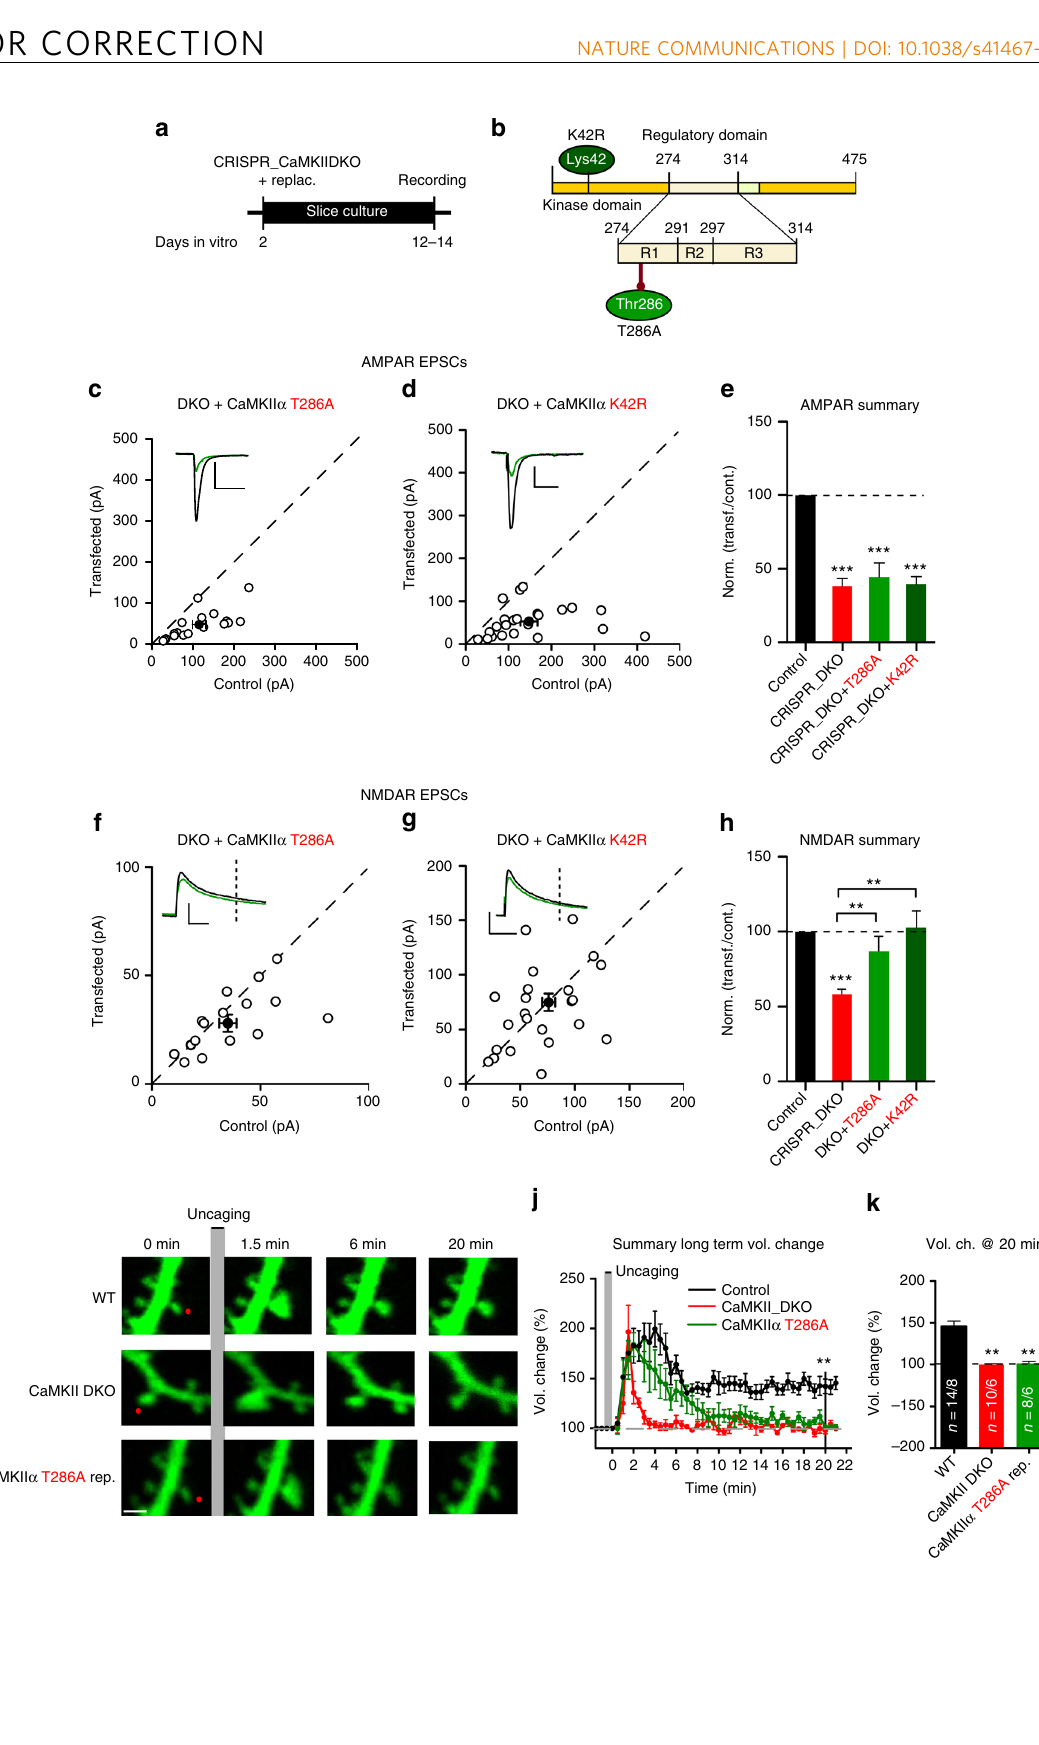
Summary long term vol.